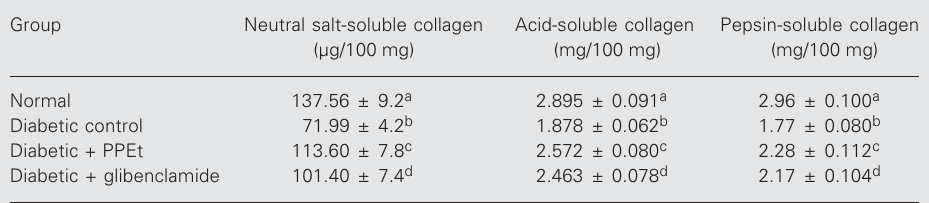
For drug administration see Table 1 legend. Data are reported as means ± SD for 6 rats in each group. Values not sharing a common superscript letter differed significantly at P < 0.05 (Duncan multiple range